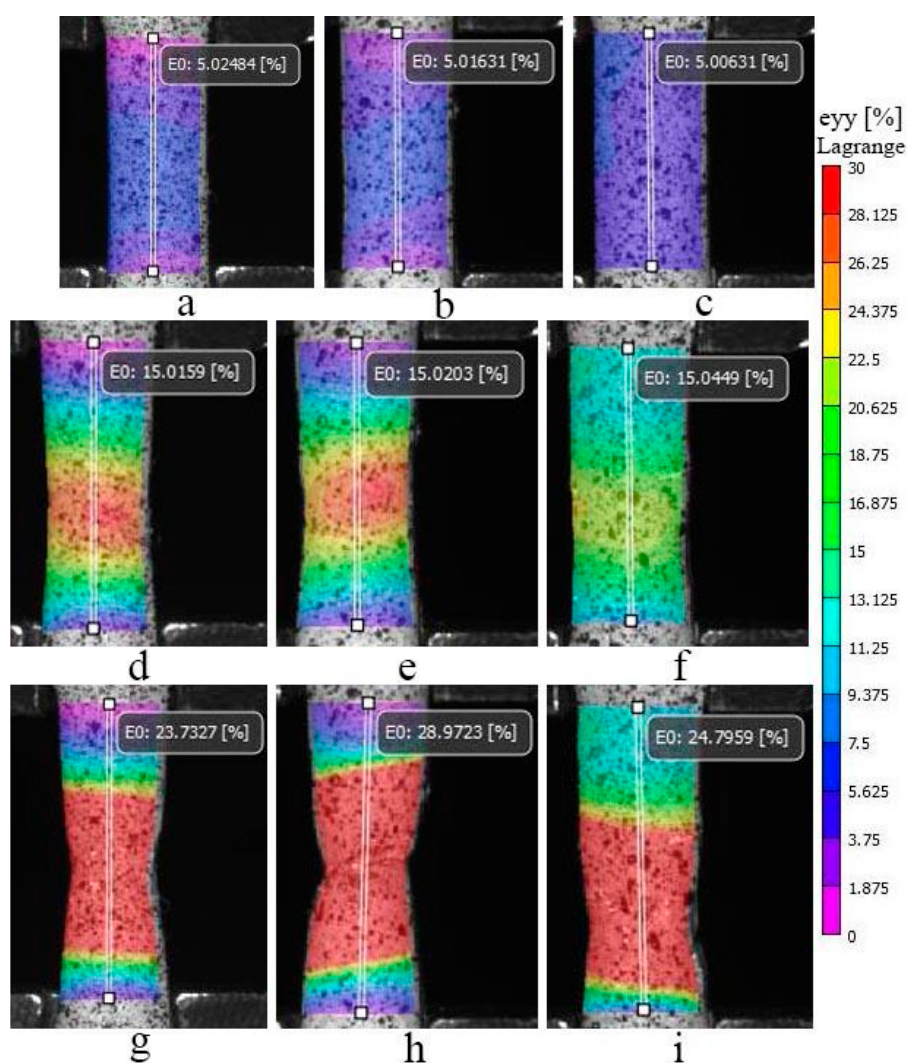
Figure 3. DIC images of tensile specimens of Ti30Nb20 ( a , d , g ), Ti40Nb10 ( b , e , h ), and Ti50Nb0 ( c , f , i ) alloys showing the strain distribution along the gauge. The microhardness of the alloys corresponded to the yield strength. The strongest alloy, Ti30Nb20, showed the highest value with 321HV, while Ti50Nb0, with the lowest yield strength, showed a value of hardness of 244 HV (Table 1). Young’s modulus values were also related to strength: E = 77.7 GPa was found for the Ti30Nb20 alloy, while Ti50Nb0 showed a Young’s modulus of 57.5 GPa (Table 1). The Young’s modulus values obtained for all three alloys are comparable to those of human bone and, therefore, can be considered suitable for biomedical application [20].